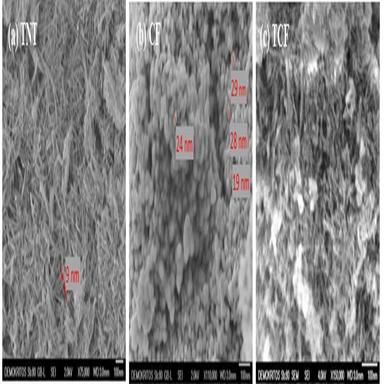
SEM images of TNT (a), CF (b) and TCF (c) samples.